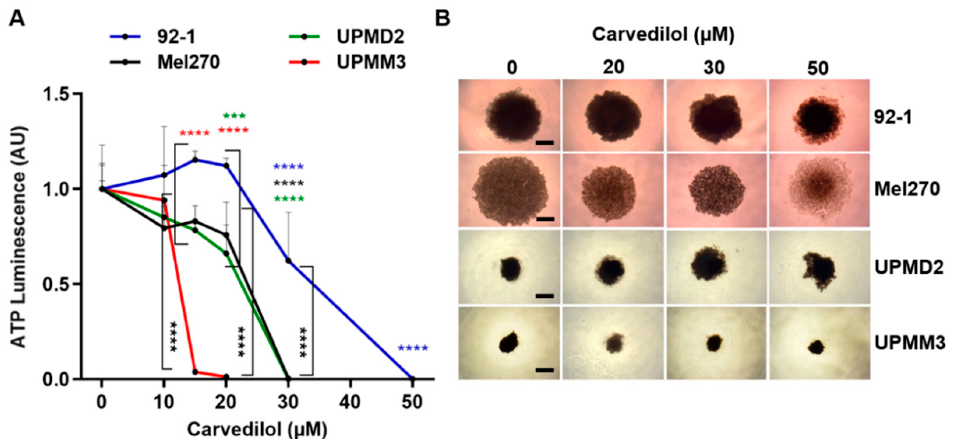
Figure 6. Cytotoxic effects of carvedilol on the viability of various 3D tumor spheroid models. Spheroids were generated from cell lines 92-1 and Mel270 or primary cell lines UPMD2 and UPMM3. Spheroids were treated with carvedilol at the indicated concentration for 7 days. ( A ) Spheroid viabil- ity was assayed with an ATP luminescence assay. The ATP luminescence of the treated spheroids was normalized to the ATP luminescence of the control spheroids (0 µ M carvedilol) and is given in arbi- trary units (AU). Representative results from 3 independent experiments are shown. The means ± SD of n = 8 spheroids for each condition are shown. Statistical analysis was performed with two-way ANOVA and Tukey’s multiple comparisons test, and the significance levels of the treated spheroids in relation to the control spheroids (0 µ M ß-blocker) are indicated in color. Significance levels are indicated at *** p < 0.001, **** p < 0.0001. ( B ) Representative microscope images (4 × magnification) of 3D tumor spheroids at the indicated concentrations of carvedilol on day 7 are shown. Scale bars indicate 500 µ